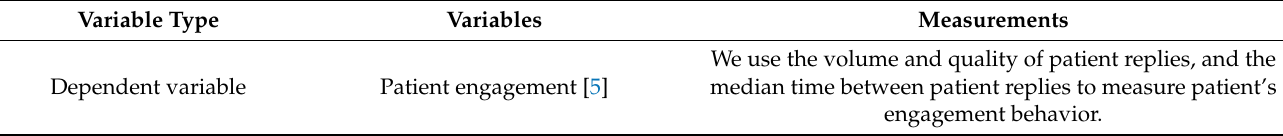
Table 1. Description of